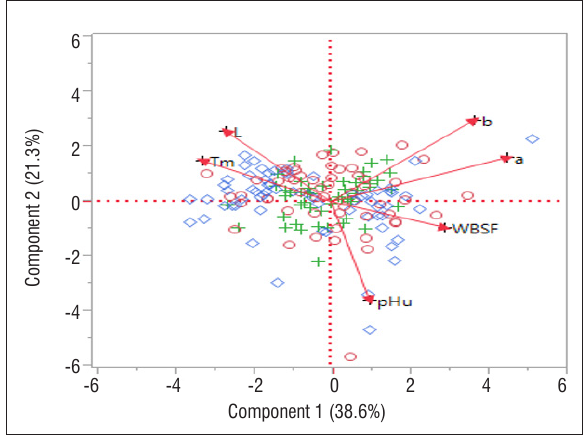
Relationship between tenderness and visual qualities of beef.